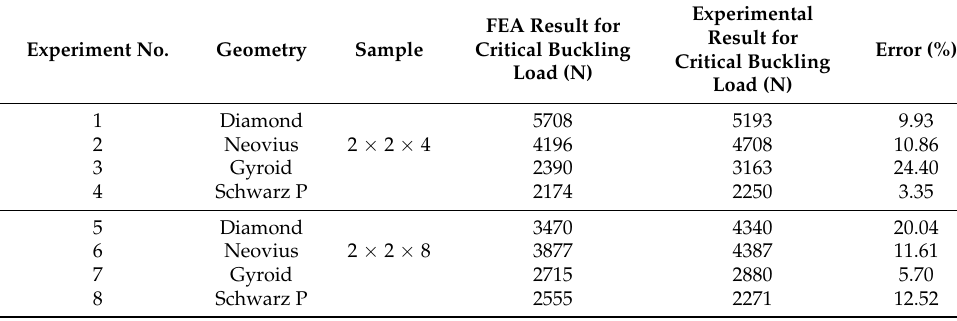
Figure 12. Height’s influence on critical buckling load. The letters D, G, N, and P are used in Graphs to represent Diamond, Gyroid, Neovius and Schwarz-P designs, respectively. The number 4 denotes a 2 × 2 × 4 arrangement, whereas the number 8 denotes a 2 × 2 × 8 configuration and 16 denotes a 2 × 2 × 16 configuration. ( a ) The Gyroid design exhibits a considerable reduction in G8 and G16 of critical buckling load compared to G4 and G8. ( b ) The Neovius design exhibits a considerable reduction in N8 and N16 of critical buckling load when compared to N4 and N8. ( c ) The critical buckling load of Diamond structures decreases uniformly with height. ( d ) Because local deformation is prevalent in Schwarz-P, it may be exploited in short column applications. Table 3. Comparison of FEA and experimental